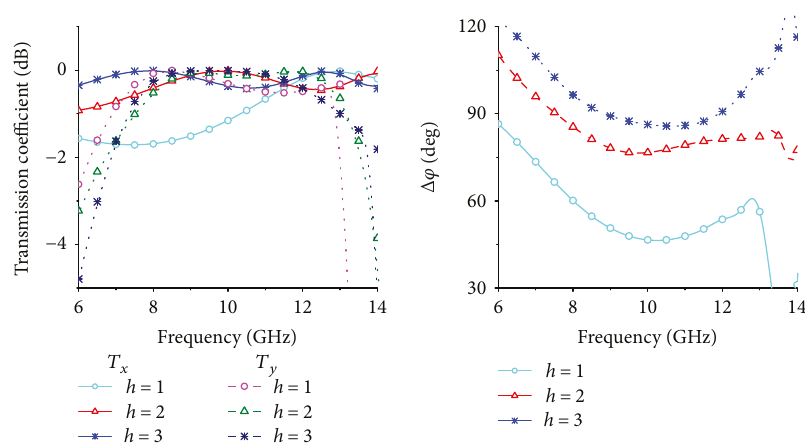
Figure 4: Simulation results of the transmitted wave for di ff erent h : Transmission coe ffi cient and phase di ff